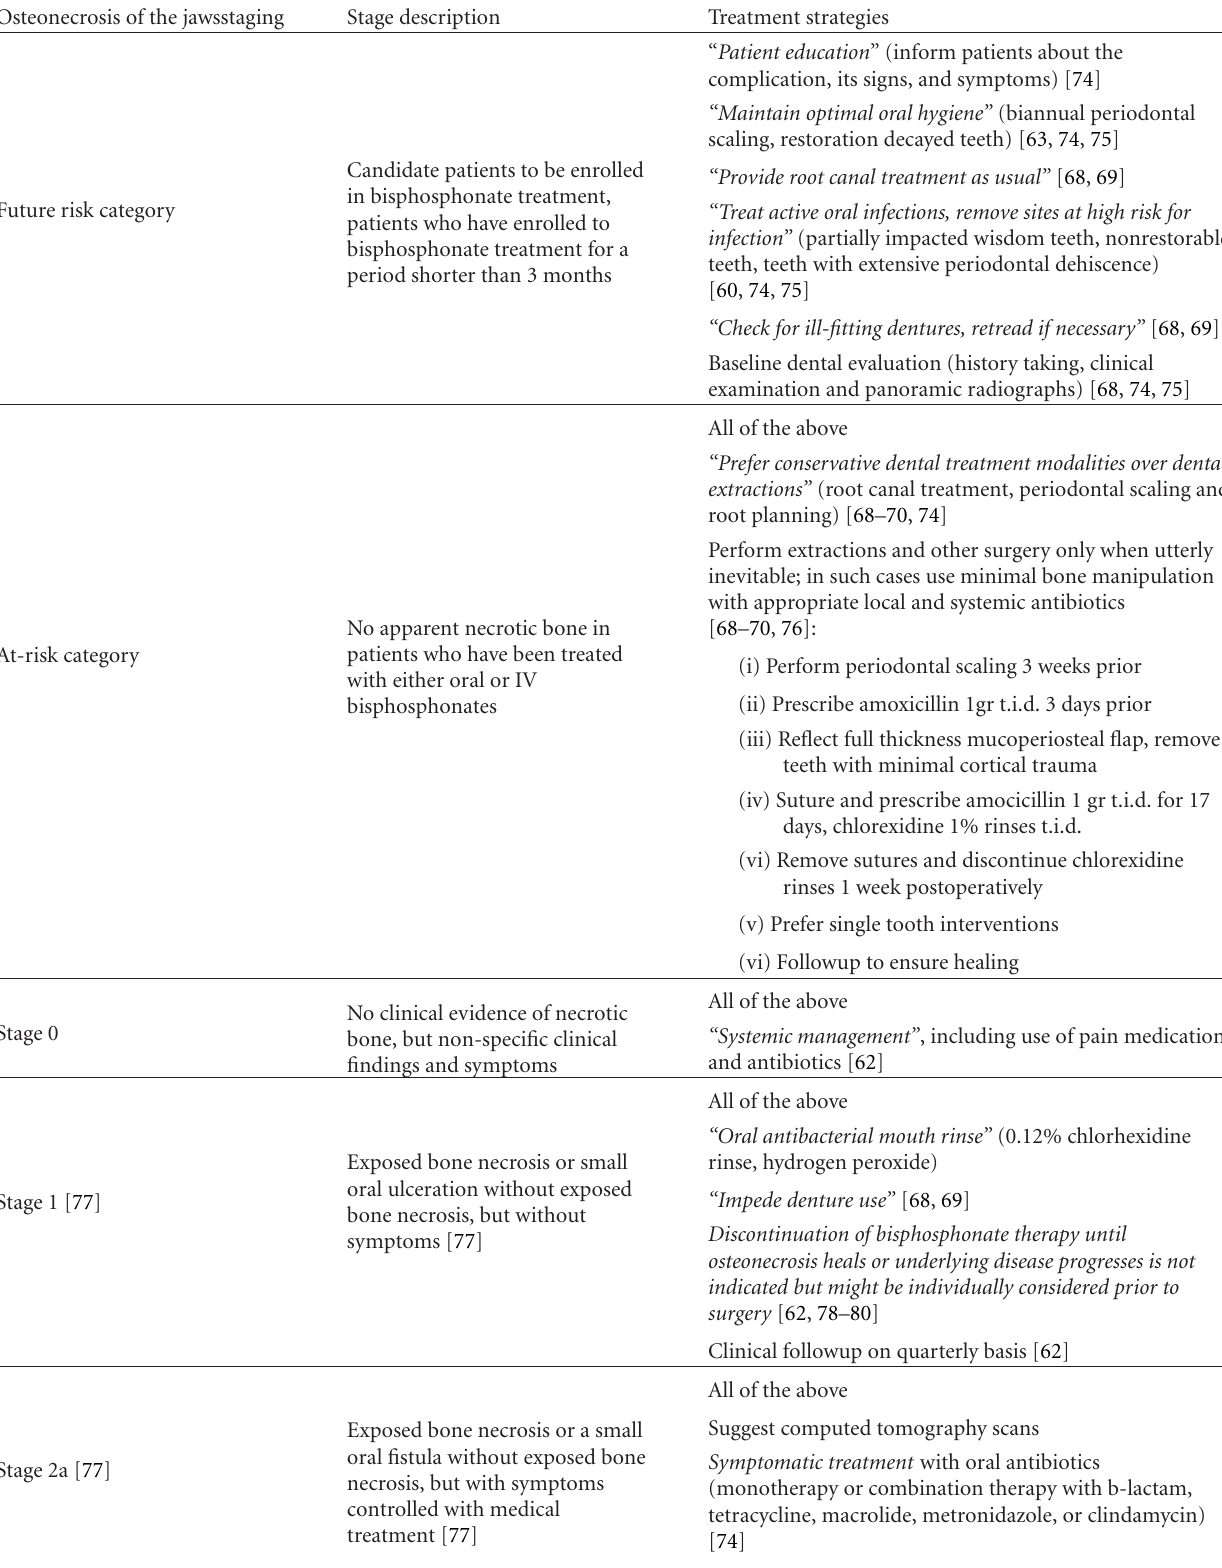
Table 1: Staging classification of osteonecrosis of the jaws by bisphosphonates and treatment strategies (from Kyrgidis et al [59], modified on the basis of current